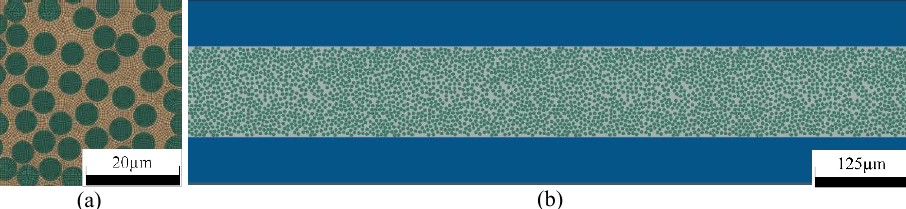
Fig. 1. Generated microstructure using a random fibre placement algorithm (a) and entire 1 mm length model including homogenised half-plies above and below